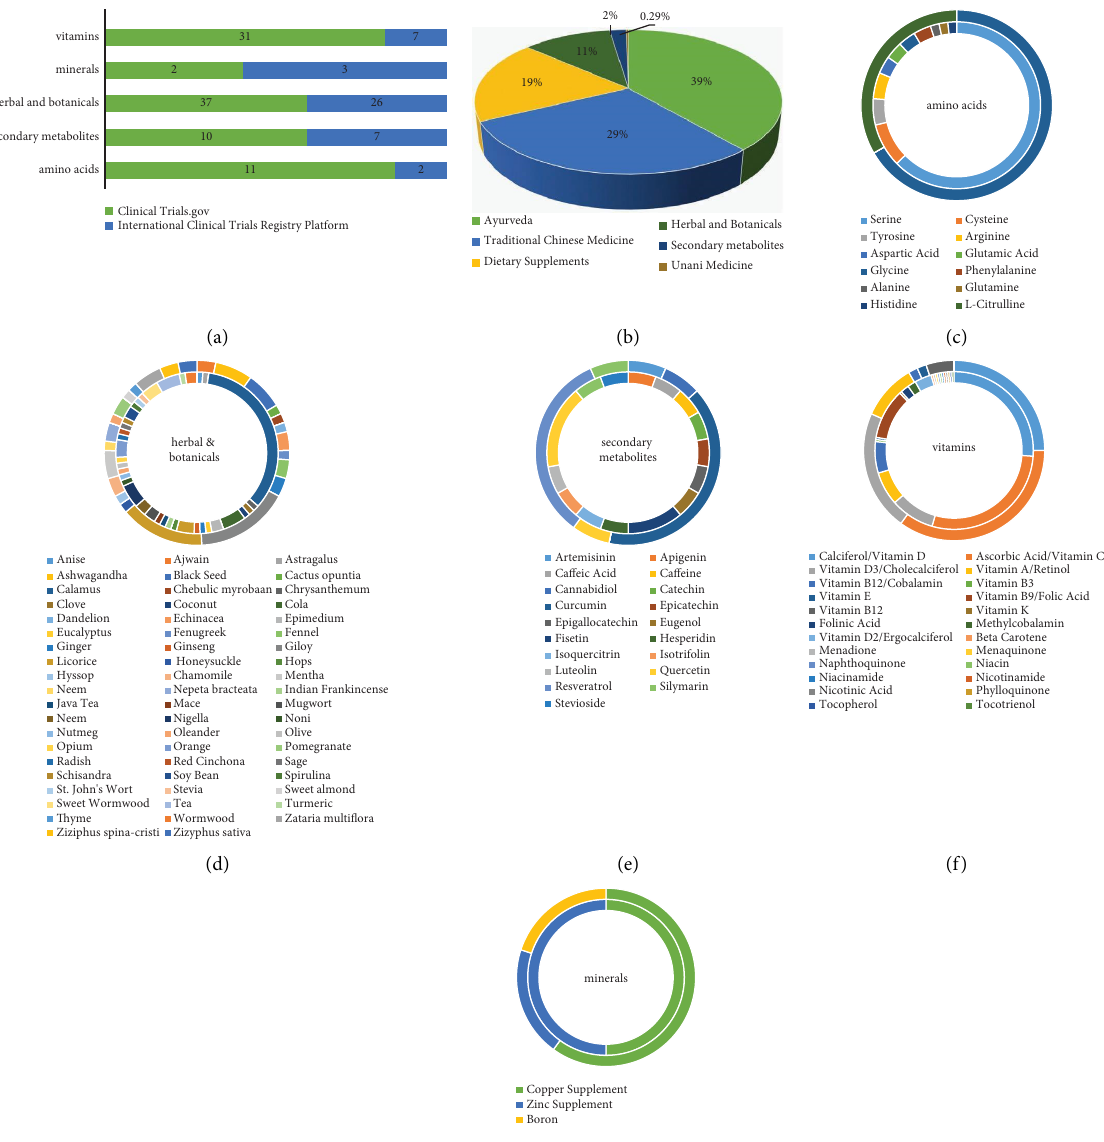
Figure 2: Schematic representation of registered clinical trials for COVID-19 on drug supplements, herbal and botanicals, and plant- derived secondary metabolites. Data collected from two registry platforms (ClinicalTrials.gov and ICTRP). (a) Bar chart representing number of clinical trials registered in ClinicalTrials.gov and ICTRP for vitamins, minerals, herbal and botanicals, secondary metabolites, and amino acids, (b) pie chart showing analysis of data collected from ICTRP on the percentage share of Ayurveda (39%), traditional Chinese medicine (29%), dietary supplements (19%), herbal and botanicals (11%), secondary metabolites (2%), and Unani medicine (0.29%) in registered clinical studies apart from vaccines. Doughnut representation showing individual category on (c) amino acids, (d) herbal/ botanical, (e) secondary metabolites, (f) vitamins, and (g) minerals registered for clinical trials at ClinicalTrials.gov (inner doughnut) and ICTRP (outer